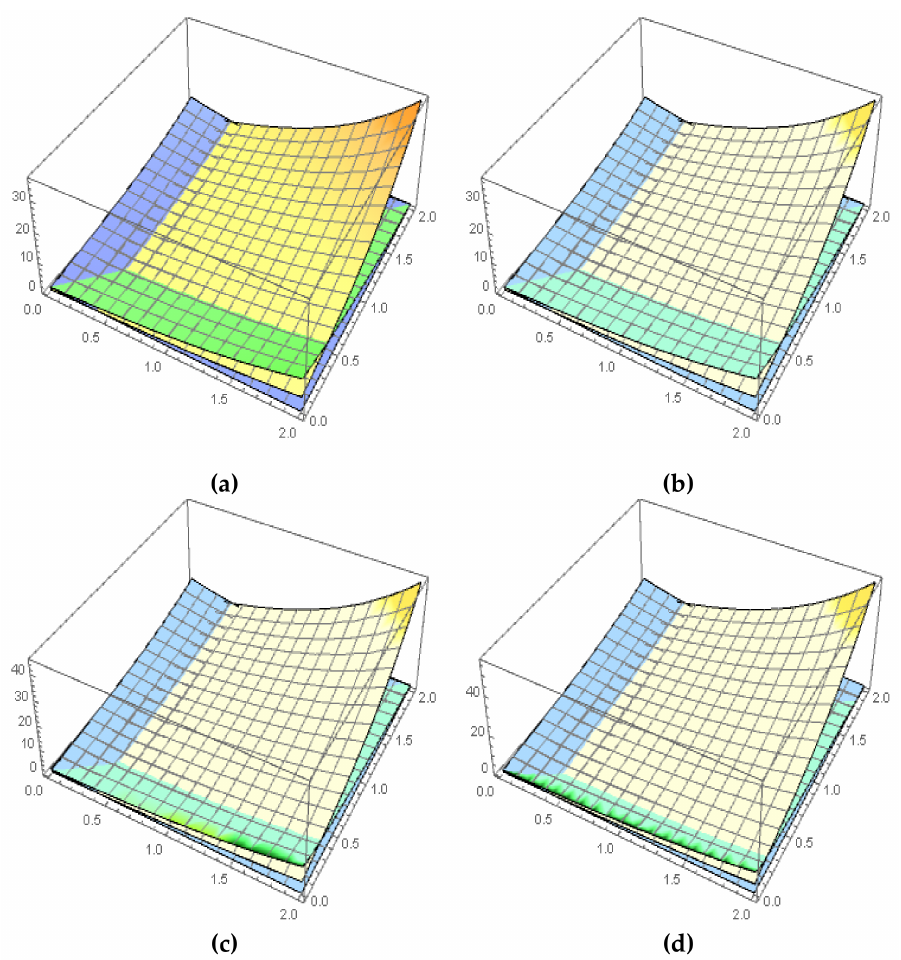
Figure 3. 3D-Surfaces Plot of Exact solutions of ( U , V , W ) the 7 − th approximate solution V W ( U ) , for system (33), with 𝓉 ∈ [ 0,2 ] , and 𝓍 ∈ [ 0,2 ] and 𝓎 = 0.4, at various values of 7 , 7 , 7 𝒶 . ( a ) ( U , V , W ) . ( b ) ( U 7 , V 7 , W 7 ) : 𝒶 = 1. ( c ) ( U 7 , V 7 , W 7 ) : 𝒶 = 0.8. ( d ) ( U 7 , V 7 , W 7 ) : 𝒶 =